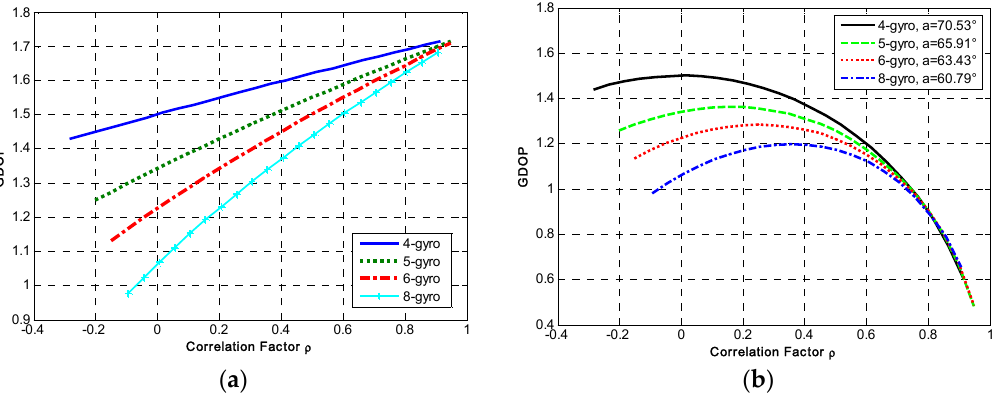
Figure 10. The relationship between correlation factor and GDOP. ( a ) Configuration scheme 1; ( b ) configuration scheme 2.